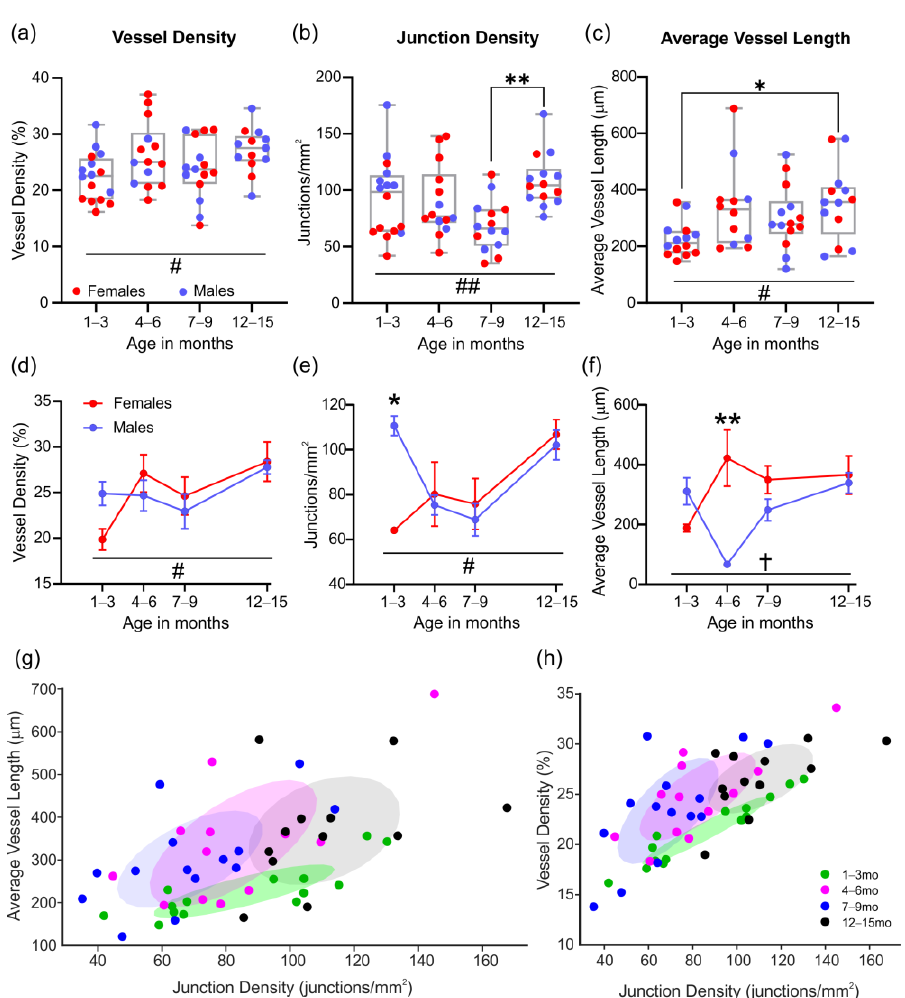
Figure 3. Vascular network features from the cortex in aging 3xTg-AD mice. Vessel density ( a ), junction density ( b ), and average vessel length ( c ) for male and female mice with increasing age. There is an increase in junction density with age ( b ) that is associated with increasing vessel length ( c ). Male and female differences were observed in vessel density ( d ), junction density ( e ), and average vessel length ( f ). Scatter plots showing the relationship between junction density and average vessel length ( g ) or vessel density ( h ), with ellipses showing positive covariance for each age group. * p < 0.05, ** p < 0.01. # shows a significant effect of age with # p < 0.05, ## p < 0.01; † shows a significant effect of sex with † p < 0.05. Data shown in ( d – f ) as mean ± SEM.